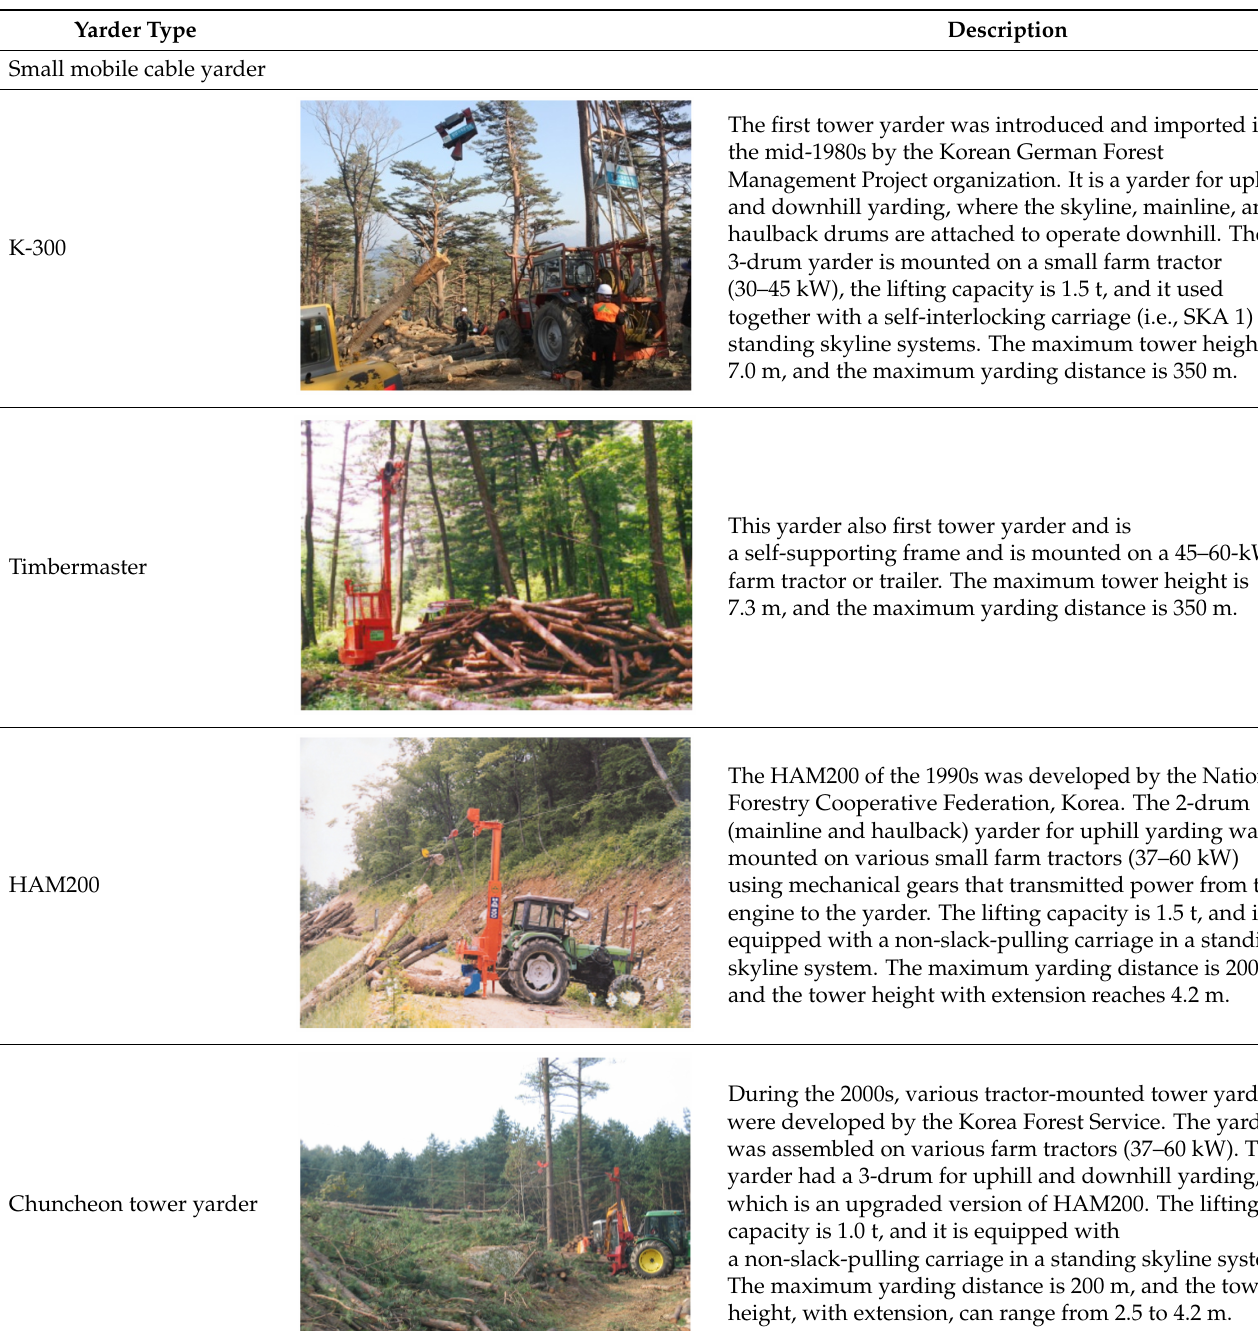
Table 2. Summary of small mobile cable yarders in Korea